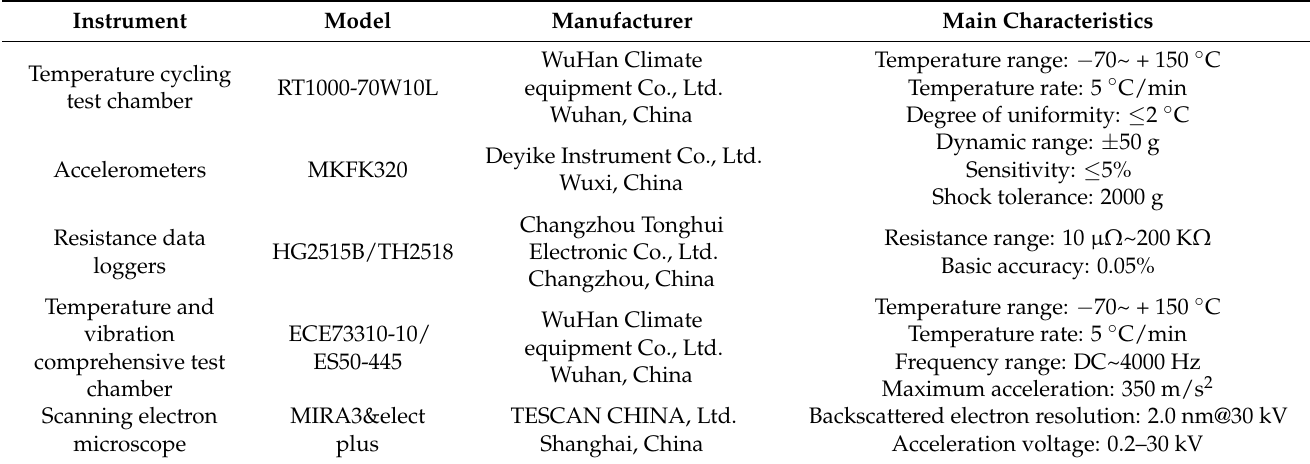
Table 2. Instruments used in this paper.